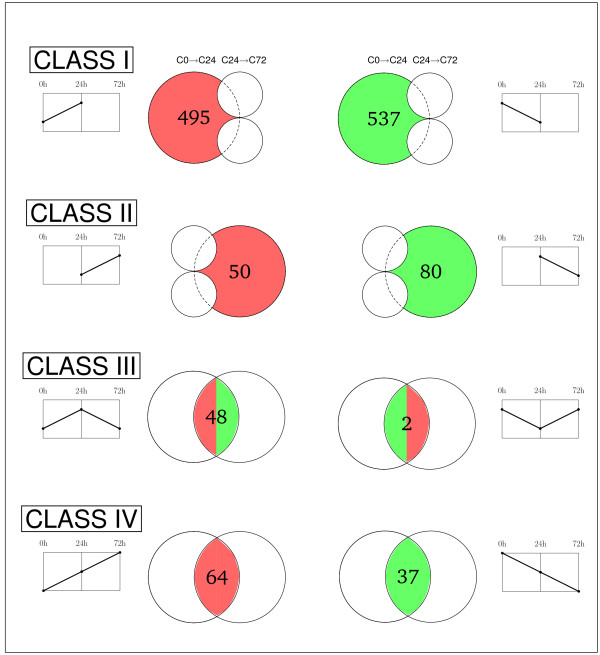
Classification of differentially expressed genes involved in wing imaginal disc regeneration. According to the expression changes in early and late regeneration stages, genes in the transcriptomes were organized in four classes: Class I, genes with differential expression only in the first 24 hours; Class II, genes with differential expression only between 24 and 72 hours; Class III, genes with a significant difference between the two time periods; Class IV, genes with a sustained increase or decrease in their expression levels during regeneration. Intersections of upregulated genes (in red) and downregulated genes (in green) in a particular class are depicted using Venn diagrams. For each intersection, we display the number of genes and a generic pictogram representing the gene expression trend in C0→C24 and C24→C72.